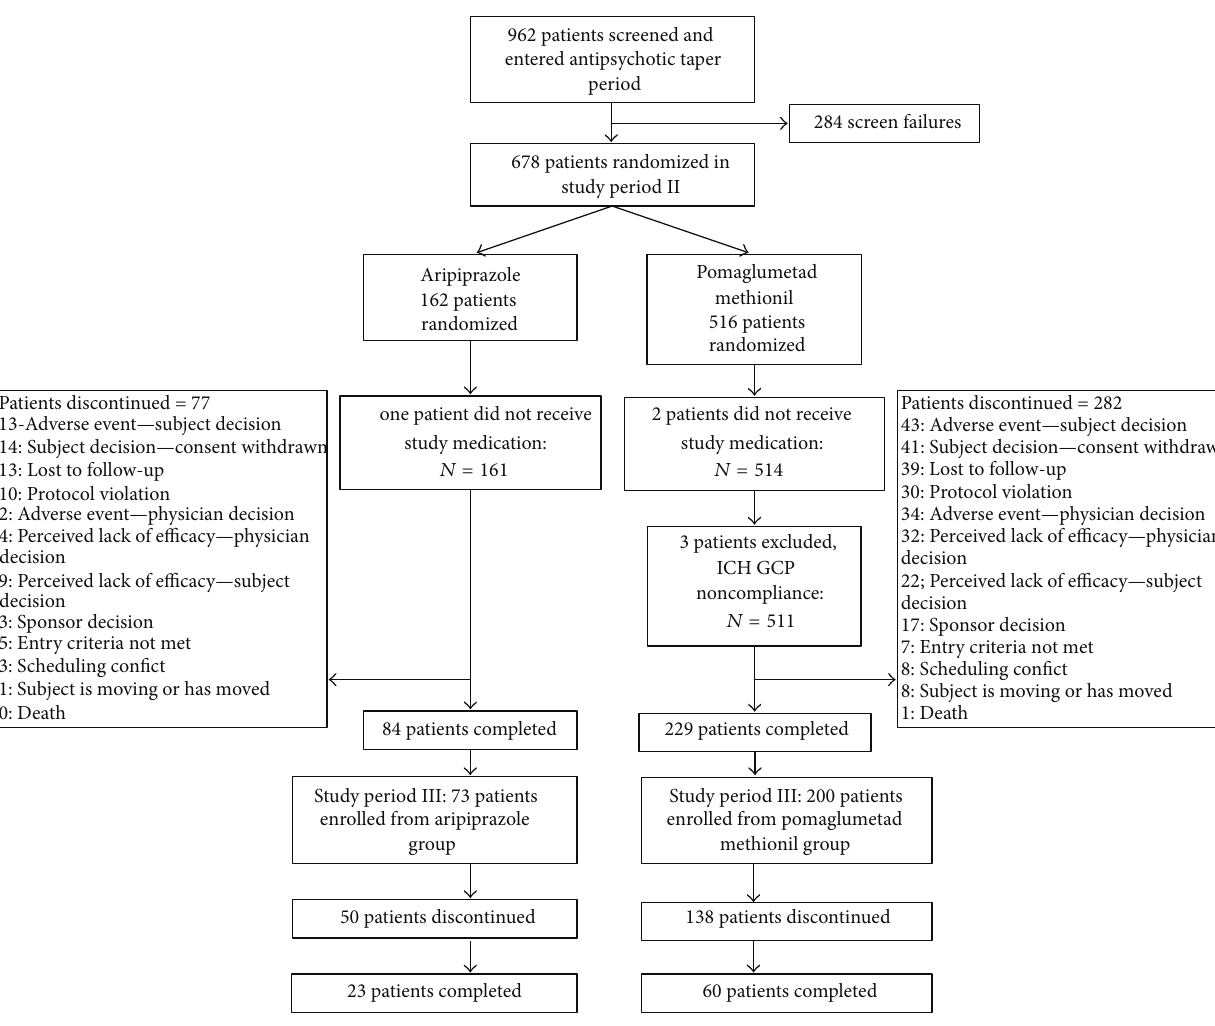
Figure 1: Patient